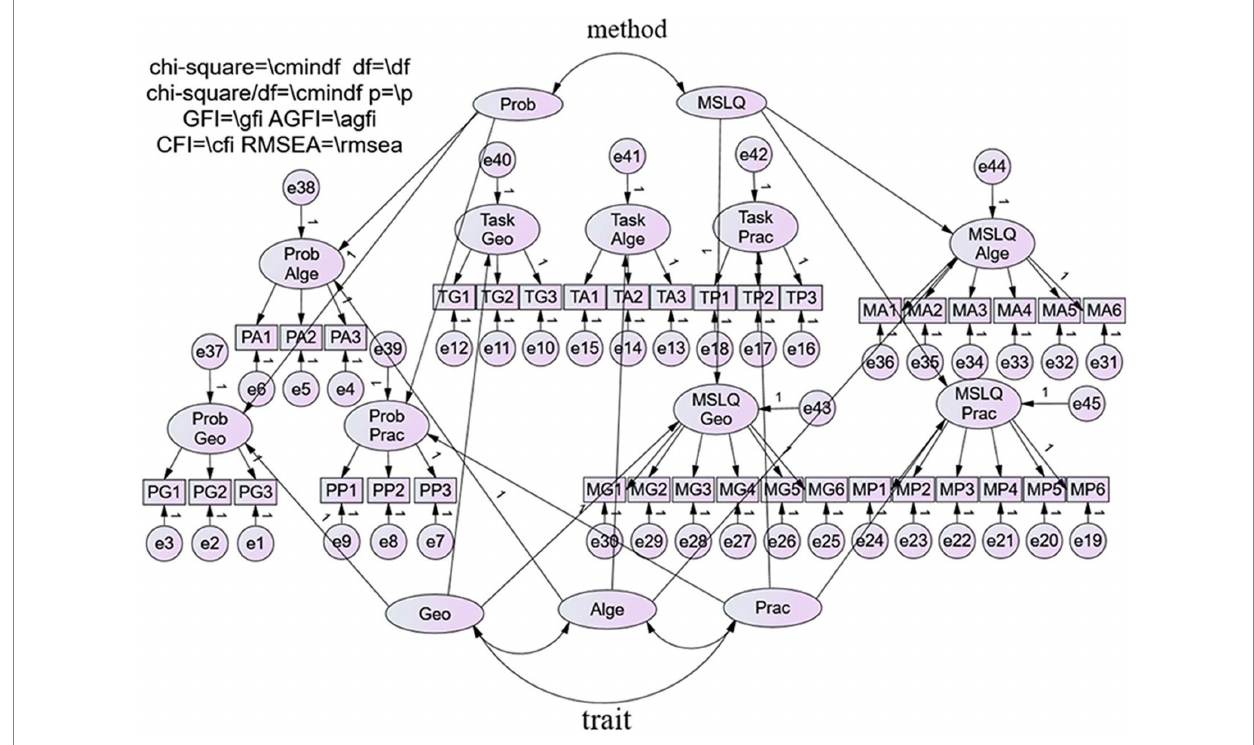
FIGURE 1 High-order confirmatory factor analysis model of multitrait-multimethod data with three correlated traits and two correlated method second-order factors with no trait–method correlation (model D). Prob, Unconventional-Math-Problem-referenced self-efficacy; MSLQ, Motivated Strategies for Learning Questionnaire; Geo, Graphics and Geometry self-efficacy; Alge, Number and Algebra self-efficacy; Prac, Synthesis and Practice